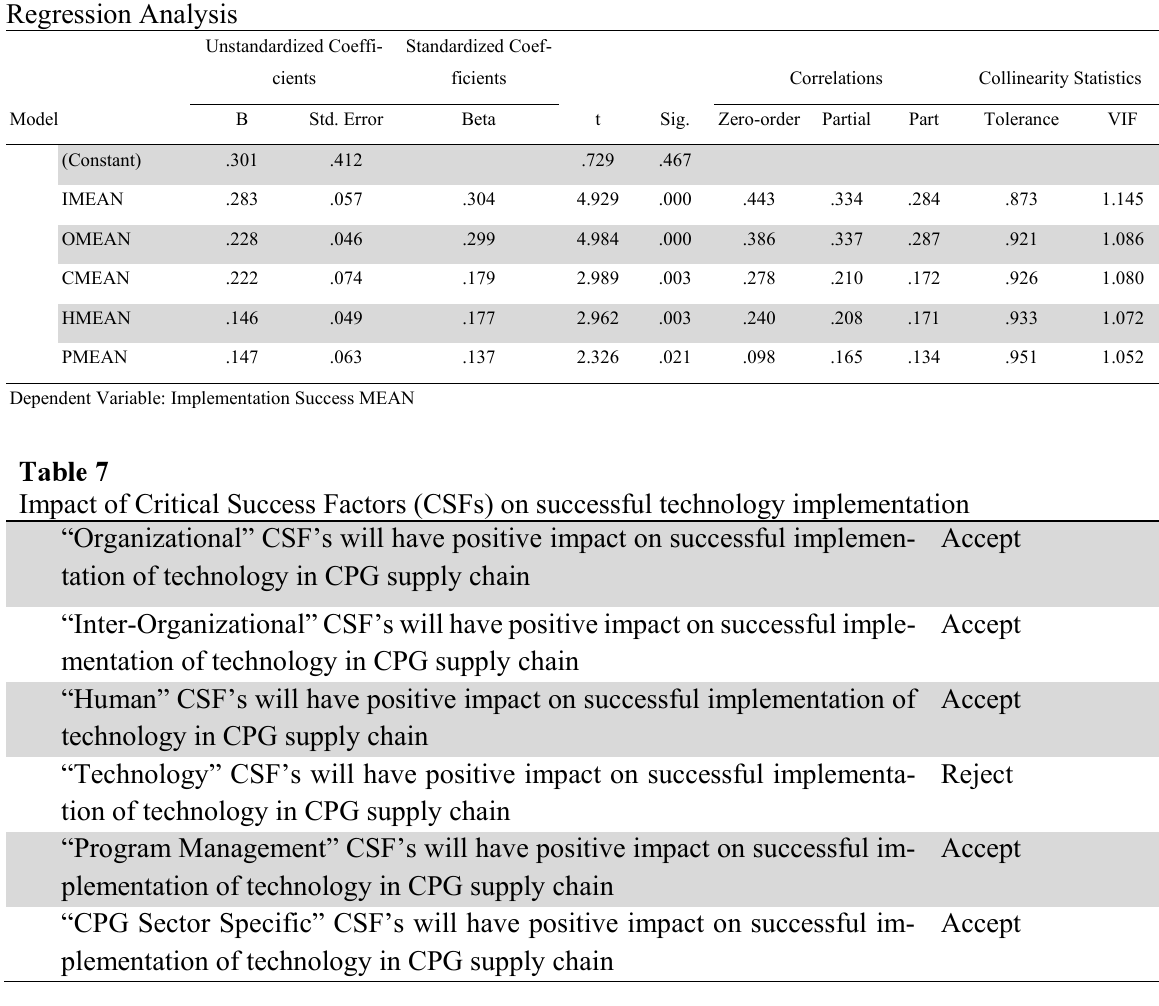
Regression Analysis